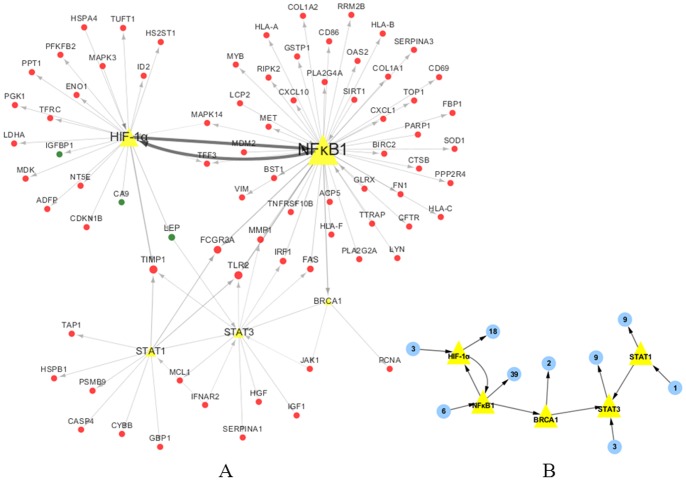
TF-gene network of these 82 differentially expressed genes in gastric cancer tissues.Red circles in A are up-regulated genes, whereas green circles are down-regulated genes and the yellow triangles are these five key TFs. B, The brief framework of this network. The circles are the clustered genes and the number of genes is shown inside. The direction of the arrow is from the Source to the Target.